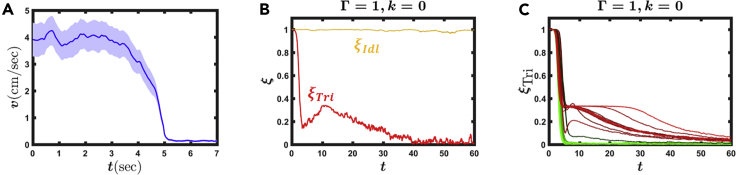
Double Tripod in Reality versus Simulation without Sensory FeedbackWe averaged 43 real locust locomotion bouts to obtain the profile of a typical bout. We then compared this empirical observation to in vitro simulations (Equation 1 with k=0).(A) Locust velocity v versus time as obtained from the averaged empirical bouts. Bouts feature a stable instance of walking, followed by a sharp transition to idling. Error represents 95% confidence intervals (see Transparent Methods under Supplemental Information).(B) ξTri(t) (red) and ξIdl(t) (yellow) versus t as obtained from Equation 1 with k = 0. Idling is stable (ξIdl(t)≈1), whereas double-tripod gradually breaks down (red). Such transient double-tripod, in and of itself, is consistent with the empirical observations. The challenge is, however, that the pattern of this double-tripod decay is irregular and stretched, as opposed to the empirically observed sharp transitions.(C) A sequence of simulated double-tripod bouts. Approximately half decay sharply, as observed in real insect locomotion (green), whereas the remaining half show irregular decay patterns (red). Together, this demonstrates that real double-tripod locomotion, i.e., stable walking followed by sudden termination, is unattainable without the feedback mechanisms (k) of Equation 1.In our simulations we used Γ = 1, k = 0, σ = 0.01, and Anm as described in Transparent Methods, under Supplemental Information.